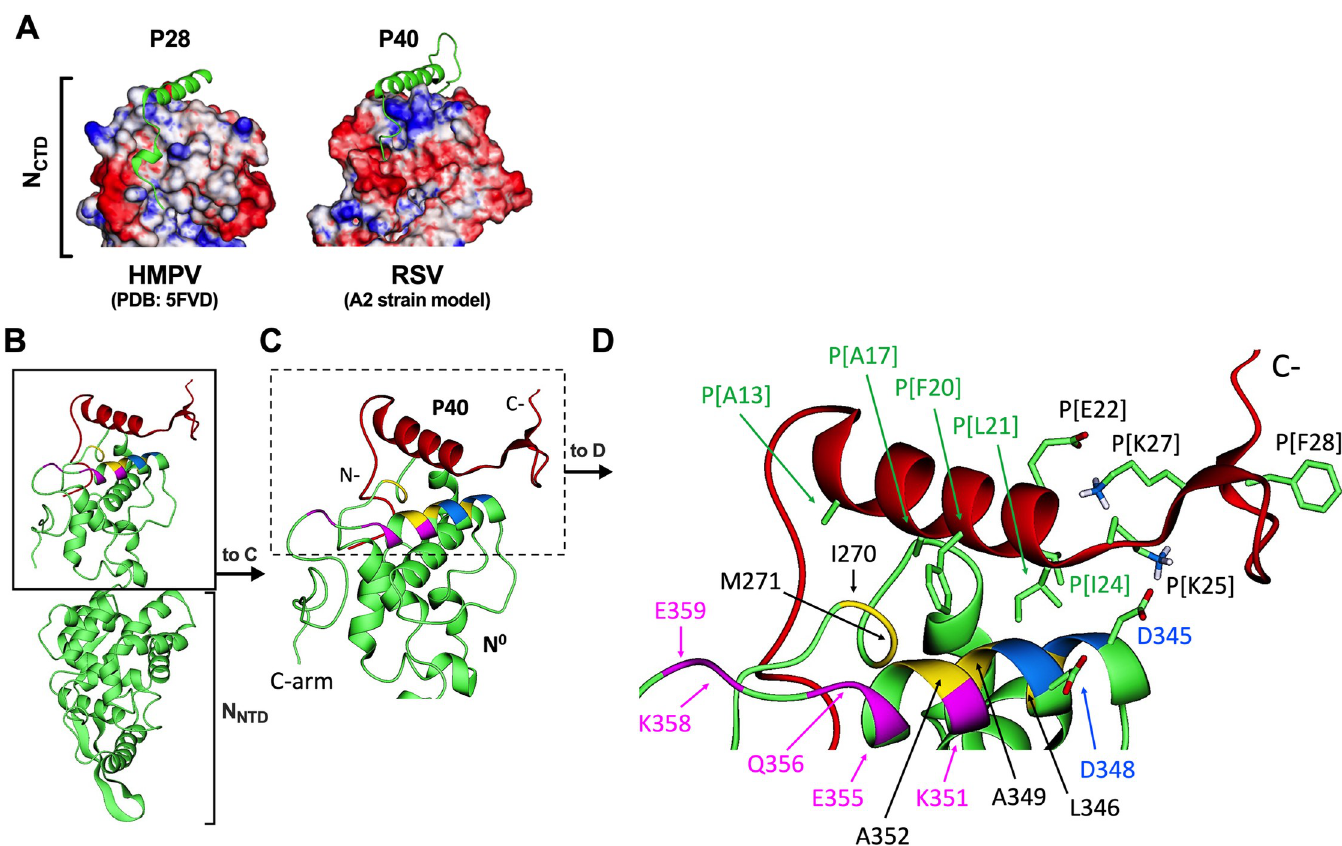
Fig 7. Molecular dynamic (MD) simulations of the effects of P mutations K27N and F28V on interactions within a complex of a peptide representing the N- terminal 40 aa of the RSV P protein (P40) with monomeric N protein (N 0 ) in solution. (A) Comparison of (left) the published [36] crystal structure (PDB 5FVD) of HMPV N 0 protein complexed with a peptide containing aa 1–28 of the HMPV P protein (P28), with (right) our model of wt RSV N 0 -P40 structure obtained from MD simulations. The C-terminal domains (CTD) of N 0 of HMPV and RSV are shown. HMPV P28 and RSV P40 are shown as green ribbons; the molecular surface electrostatic potentials of N 0 are colored red (negative potential) and blue (positive). (B, C, D) Ribbon diagram models of the RSV N 0 protein (green) complexed with wt P40 (red) generated from the MD simulations upon full equilibration (see Materials and Methods for details). Panel B shows the complete N 0 protein complexed with P40: the NTD (aa 31–249) of the N 0 protein is indicated with a bracket at the bottom (the N-term arm aa 1–30 is removed from full-length N to create the soluble N 0 ), and the CTD (aa 256–359) and C-term arm (aa 360–391), together with the P40 peptide (red), are boxed at the top with a solid line and shown in an expanded view in C. In panel C, P40 and the interface with N 0 CTD are boxed with a dotted line and shown in an expanded view in D. In panel D, key residues (see discussion in the text) are identified by sequence position: P40 residues are labeled as P[]; all other residues are in N 0 . In some cases, aa side chains are shown. In panels C and D, color-coding was used to indicate critical residues of N 0 involved in persistent H-bond/salt-bridge and hydrophobic/nonpolar interactions with P40: (i) blue indicates N 0 residues [D345] and [D348] interacting frequently with [K25] of P40; (ii) yellow indicates hydrophobic N 0 residues I270, M271, L346, A349, A352 involved in persistent interactions with several nonpolar residues of P40 (A13, A17, F20, L21 and I24) thus providing a bed of nonspecific hydrophobic interactions upon which the P40 helix rests; and (iii) purple indicates N 0 residues E355, K351, E359, Q356, K358 (ranked in decreasing order of importance) involved in interactions with the P40 mutants but not with the wt P40 that is shown in this